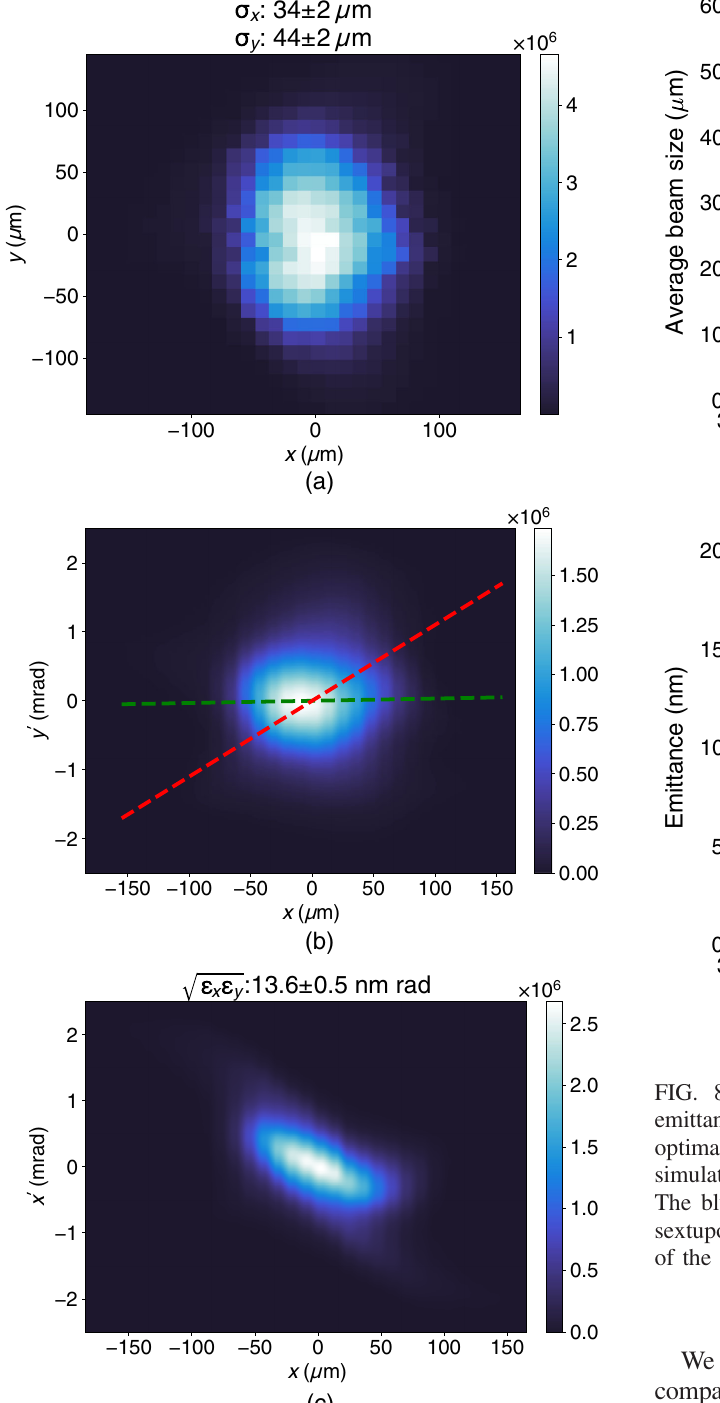
FIG. 7. (a) x - y , (b) x - y 0 , and (c) x - x 0 projections of the reconstructed four-dimensional density matrix at the sample location with sextupole correction. The dashed green line in (b) shows the correlation between x and y 0 which is seen to be near 0. Contrast this to the large correlation in the x - y 0 phase space in the inset of Fig. 4, represented by the red dashed line.